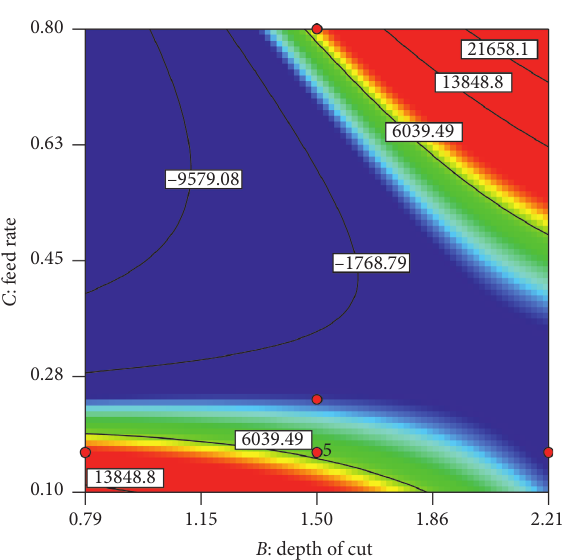
Figure 14: Chip frequency contour plots based on the cutting speed and feed rate.